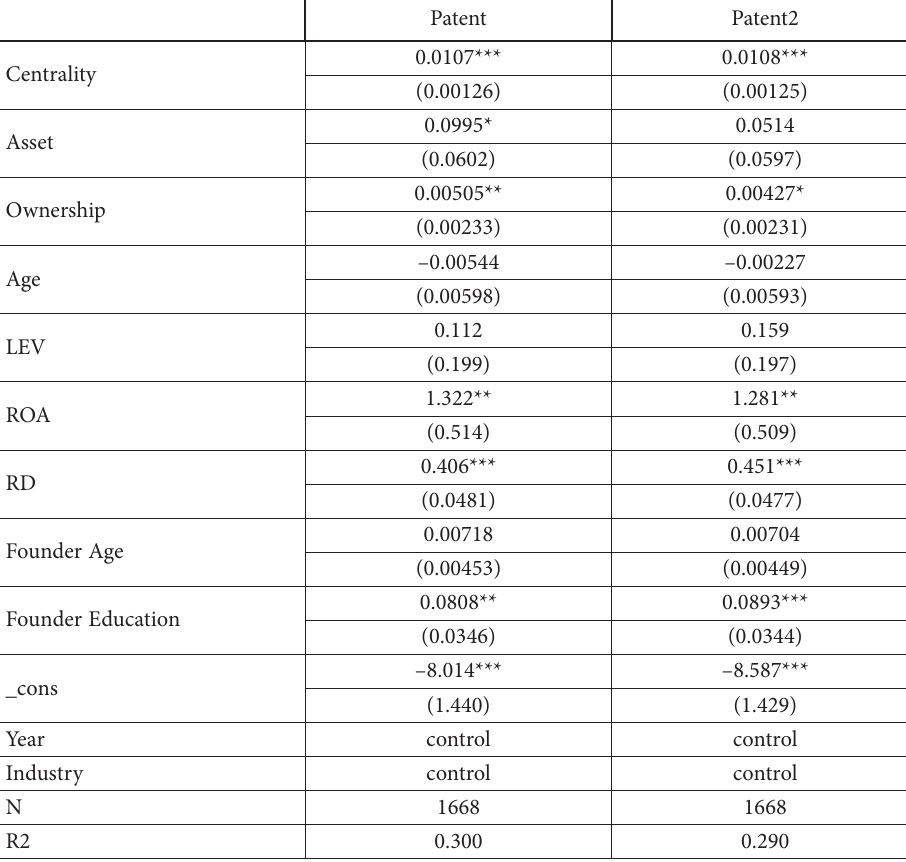
Table 4. Result of OLS regression on patents